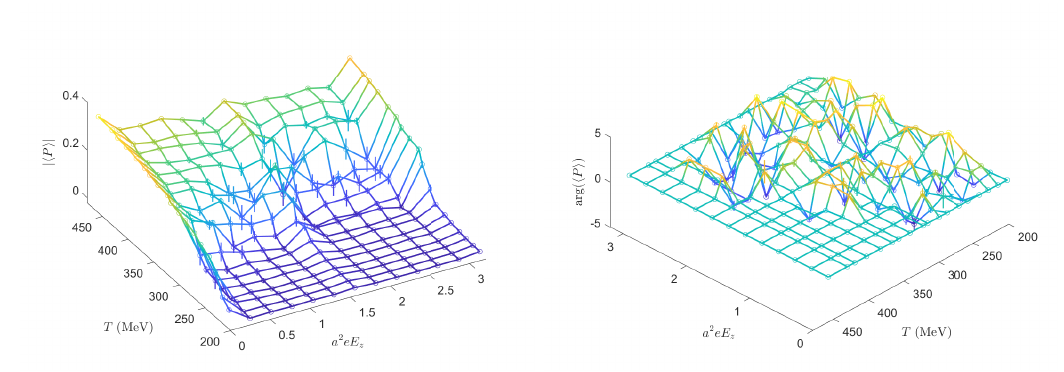
( z ) along z measured using different configurations. u